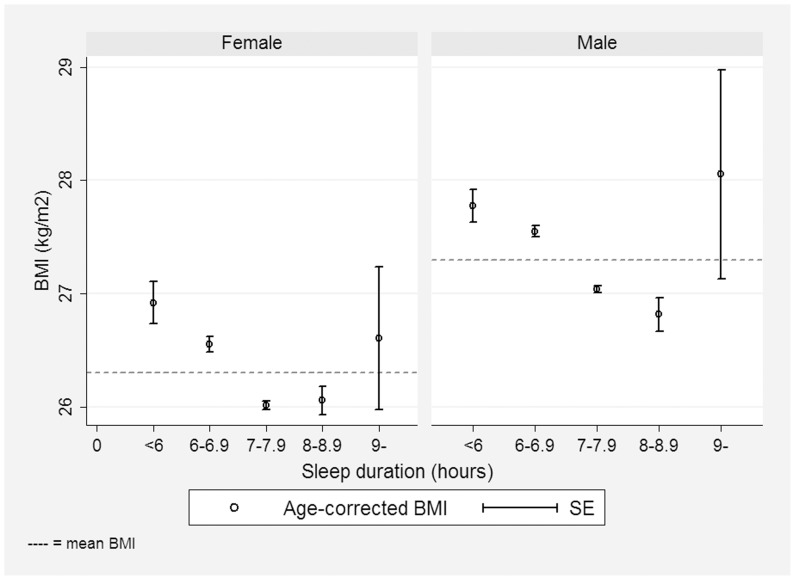
BMI by gender and sleep duration.The figure shows gender differences in age-corrected BMI by sleep duration groups (<6, 6–6.9, 7–7.9, 8–8.9 and ≥9 h).